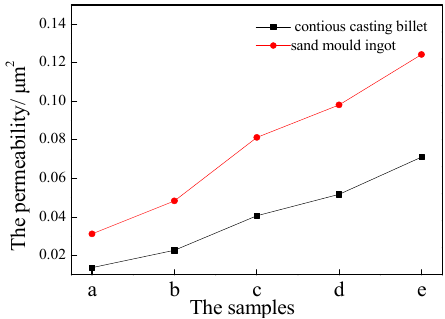
Figure 7. The permeability of the different samples from the M2 steel billets.